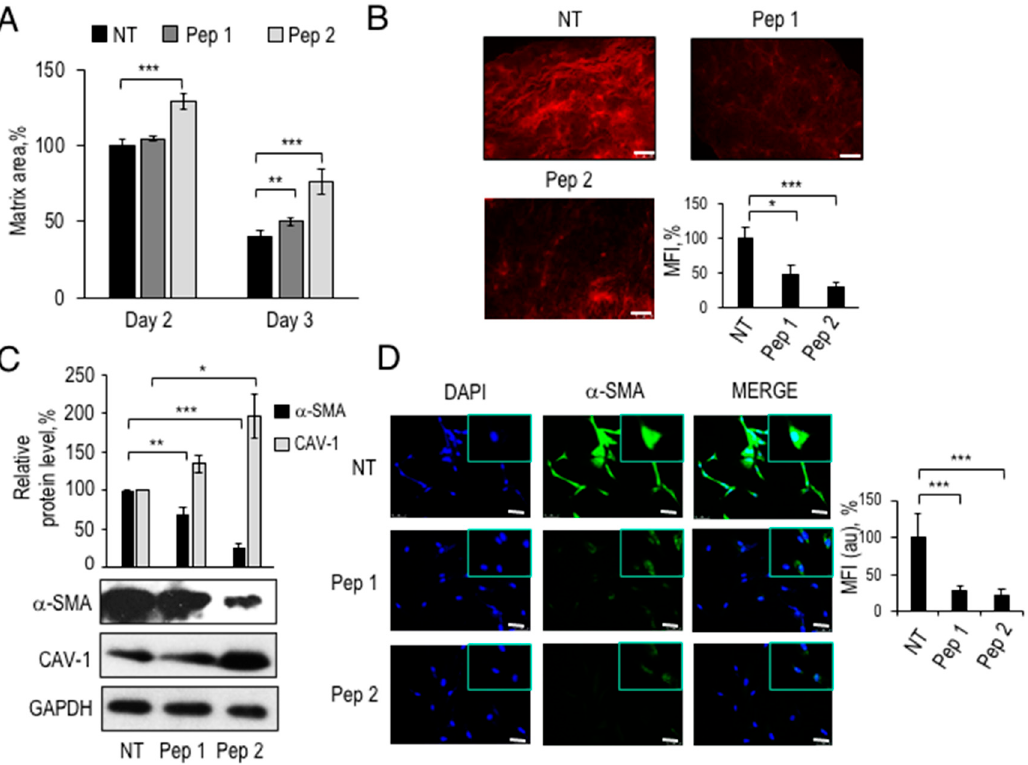
Figure 5. Modulation of CAF-like phenotype by Pep 1 and Pep 2. ( A ) Contraction assay of 5 × 10 4 TIF fibroblasts, pre-treated for 1 h at 37 ◦ C with diluents (NT) or 100 nM Pep 1 or Pep 2 in DMEM-10% FBS. TIF cells were mixed with a collagen I solution, in absence or presence of 100 nM Pep 1 or Pep 2. Peptides were added every day for 3 days. Matrix area contracted by untreated fibroblasts at day 2 was considered as 100% and the other samples considered relative to that. ( B ) Representative images of sections stained with 594-PSR picrosirius red of matrices obtained in ( A ), 20 × magnification, Scale bar 50 µ m. Quantitation of fluorescence signal was performed with ImageJ software. The mean fluorescence intensity (MFI) of untreated matrices was considered as 100%. ( C ) Western Blot analysis of TIF cell lysates with polyclonal anti- α -SMA, polyclonal anti-CAV-1 and anti-GAPDH antibodies. 5 × 10 4 TIF were seeded in 6 well plates in DMEM-10% FBS, grown for 24 h, serum-starved for 6 h, and then exposed to 100 nM Pep 1 or Pep 2 peptides in the presence of DMEM-10% FBS. Peptides were re-added to the medium after 24 h and total cellular lysates were prepared after 48 h. Densitometric analysis of Western Blot is shown on top. The whole blot image can be found in Figure S7. ( D ) For immunofluorescence analysis, 2 × 10 4 fibroblasts were seeded in DMEM-10% FBS on cover slips for 24 h, serum-starved for 6 h and treated with Pep 1 or Pep 2 in DMEM-10% FBS. Peptides were re-added every day to the medium for 72 h. Cells were fixed in 4% PFA and stained with DAPI or anti- α -SMA antibody. Immunofluorescence images (20 × Magnification and 63 × in the insets) are representative of three separate experiments. The intra-cellular fluorescence signal following staining with anti- α -SMA antibody was measured by ImageJ software and the fluorescence signal of untreated fibroblasts was considered as 100%. * p < 0.05; ** p < 0.005; *** p < 0.001, Student’s t